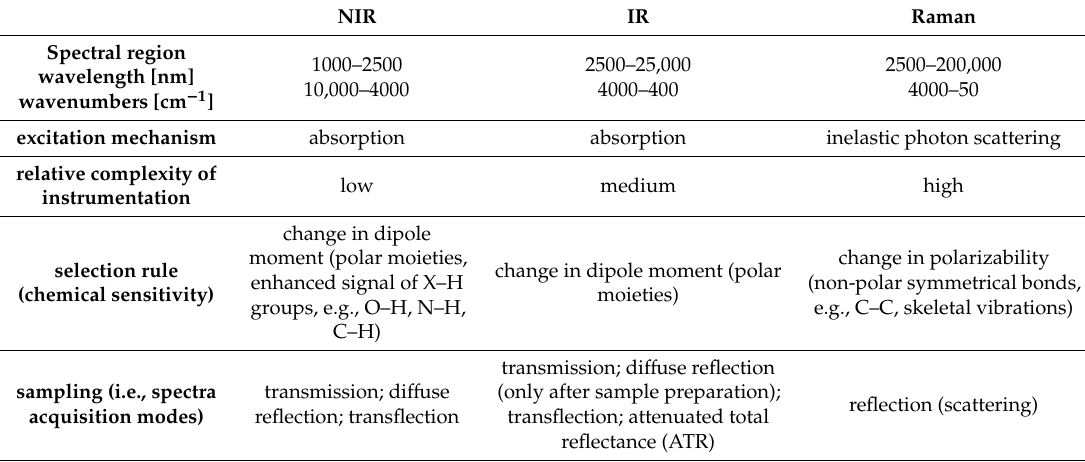
Table 2. Basic characteristics of NIR spectroscopy in comparison with competing